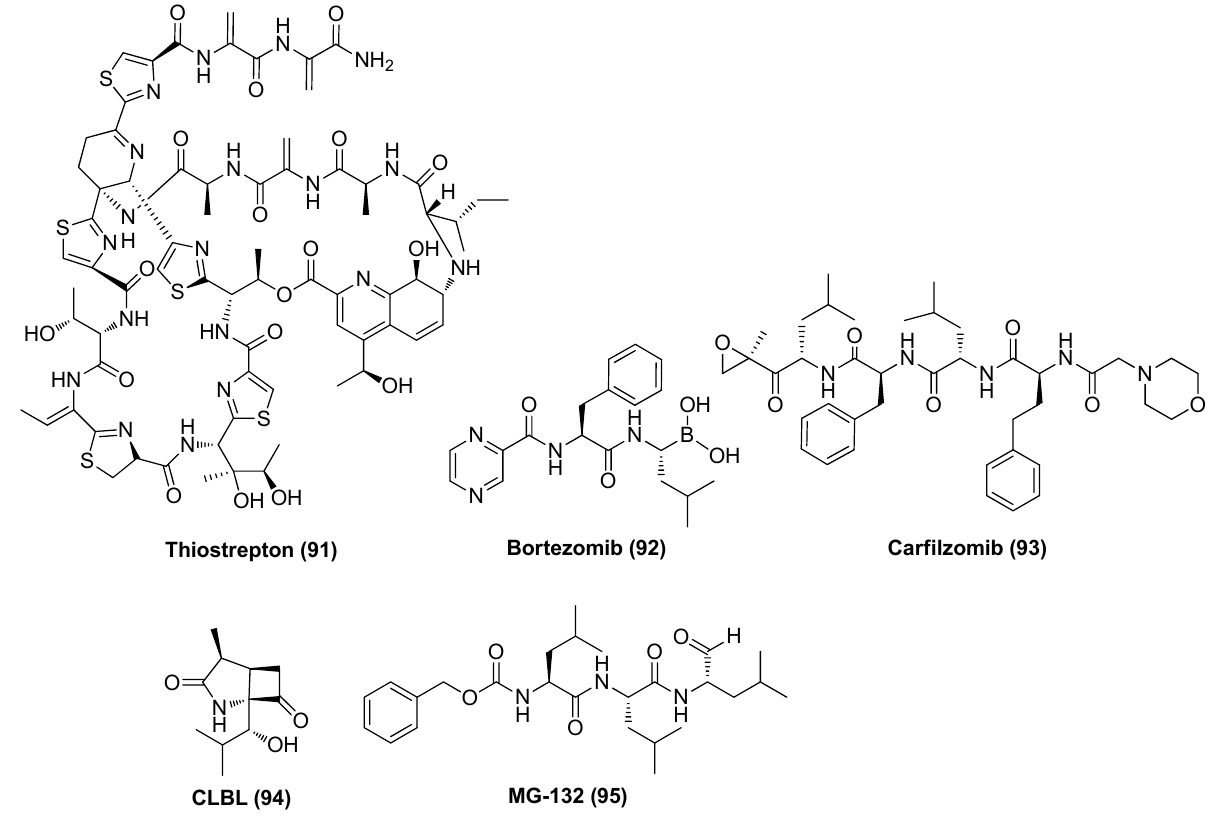
Figure 20. Chemical structures of proteasome inhibitors 91~95 as LRAs.